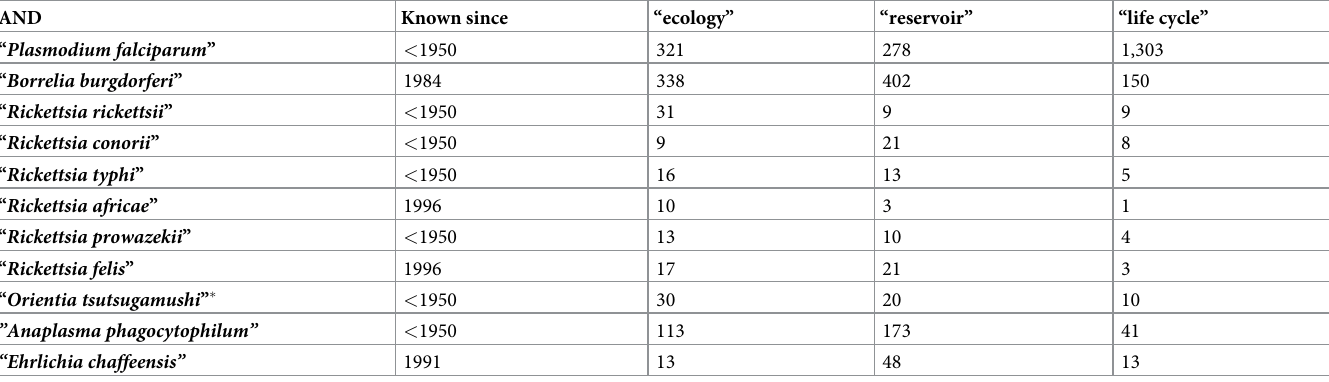
Table 2. Body of knowledge regarding the transmission of different vector-borne pathogens. Numbers represent total PubMed hits for combined All Fields searches. AND Known since